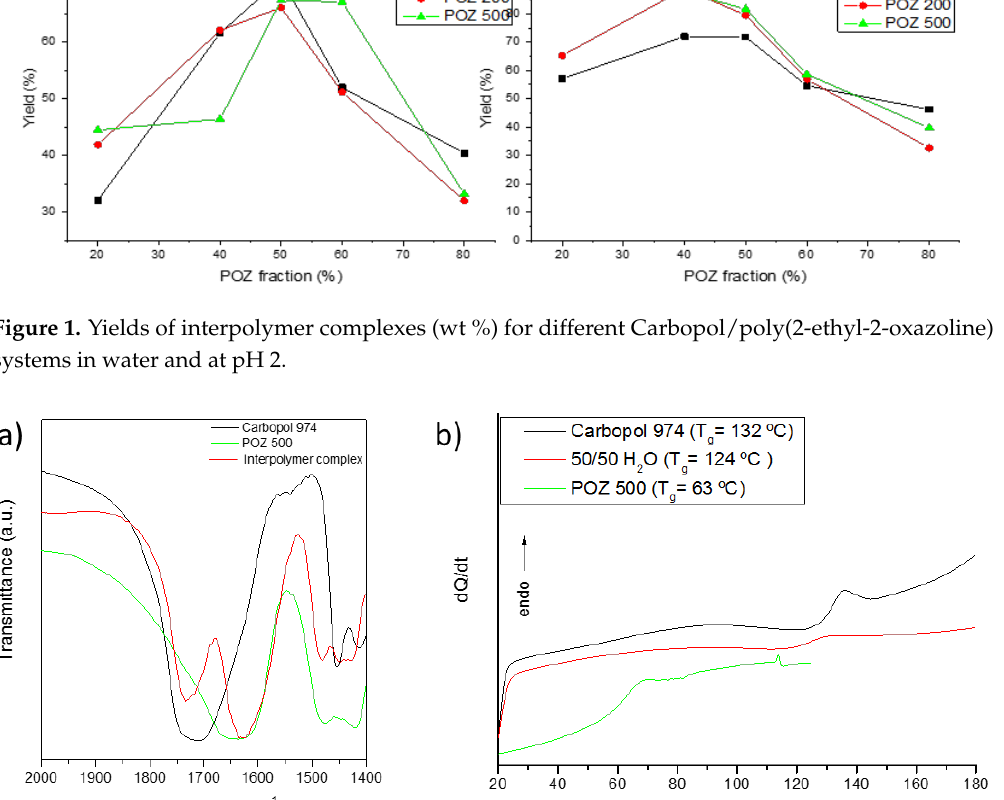
Figure 1. Yields of interpolymer complexes (wt %) for different Carbopol/poly(2-ethyl-2-oxazoline) systems in water and at pH 2.